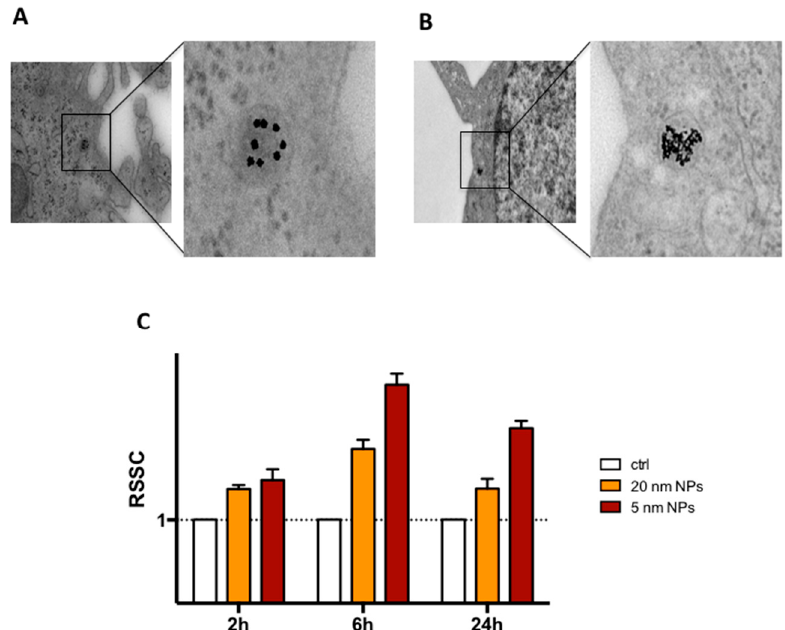
Figure 2. Cellular uptake and intracellular localization of PtNPs. High magnification TEM images of internalized 20 nm ( A ) and 5 nm ( B ) 50 µ g/mL PtNPs in THP-1 cells; ( C ) Time variation of Side Scatter in THP-1 cells treated with 50 µ g/mL PtNPs evaluated by flow cytometry. Data are normalized to untreated control (empty columns).